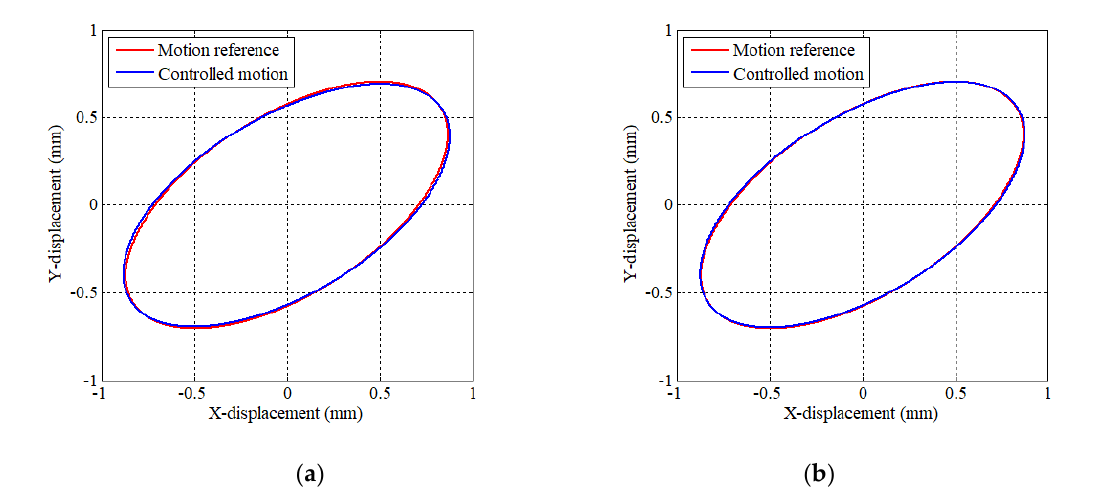
Figure 13. Effect of compensated  ( a ) without compensation and ( b ) with compensation.